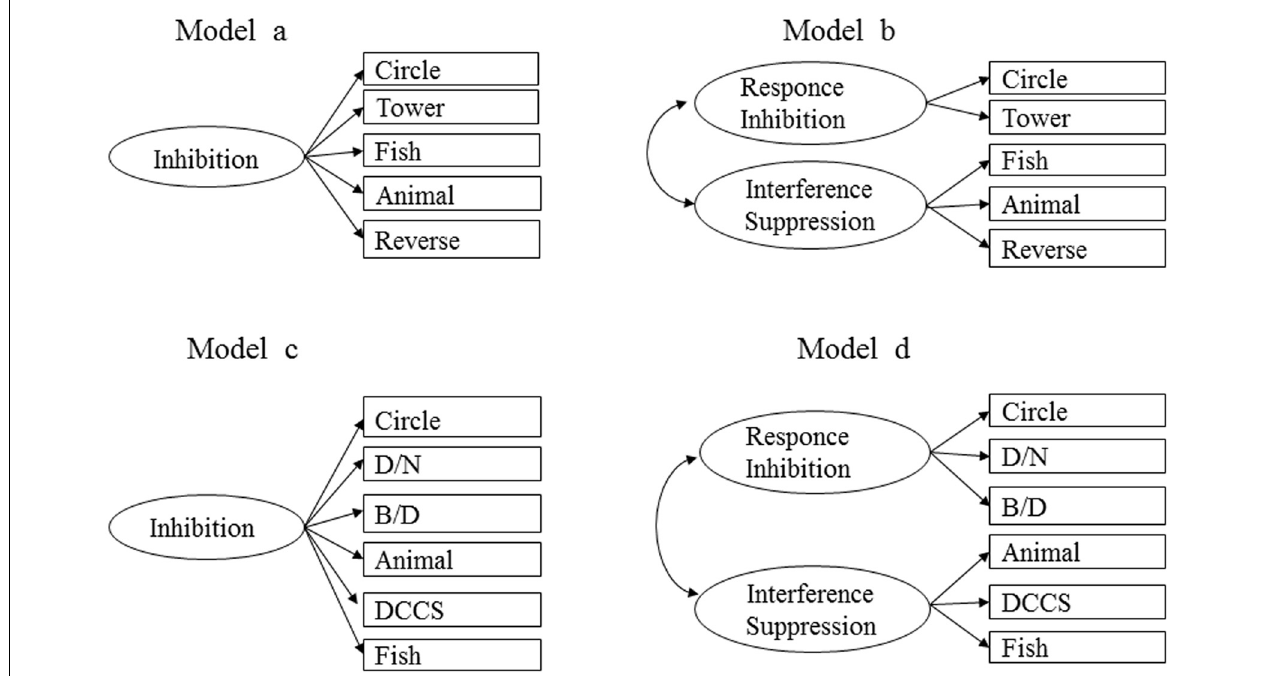
FIGURE 1 | Alternative CFA models of inhibition in toddlers.